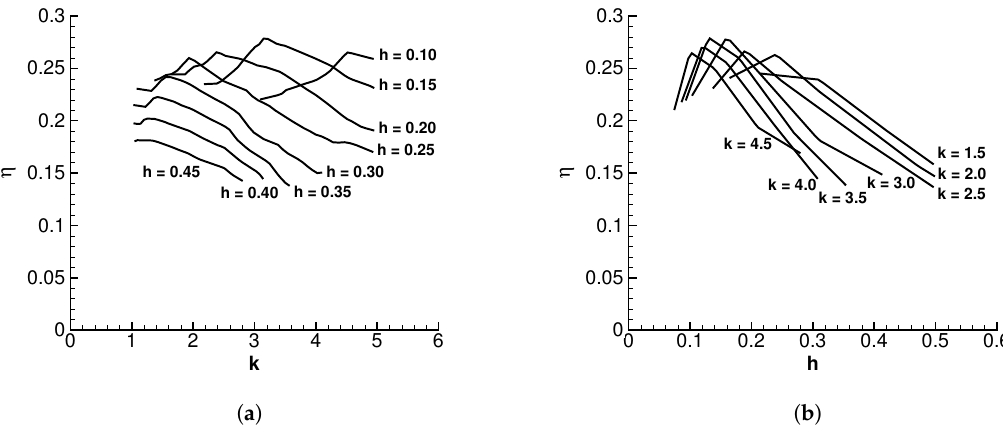
Figure 10. Propulsive efficiency with Re = 17,000 assuming constant h ( a ) and k ( b